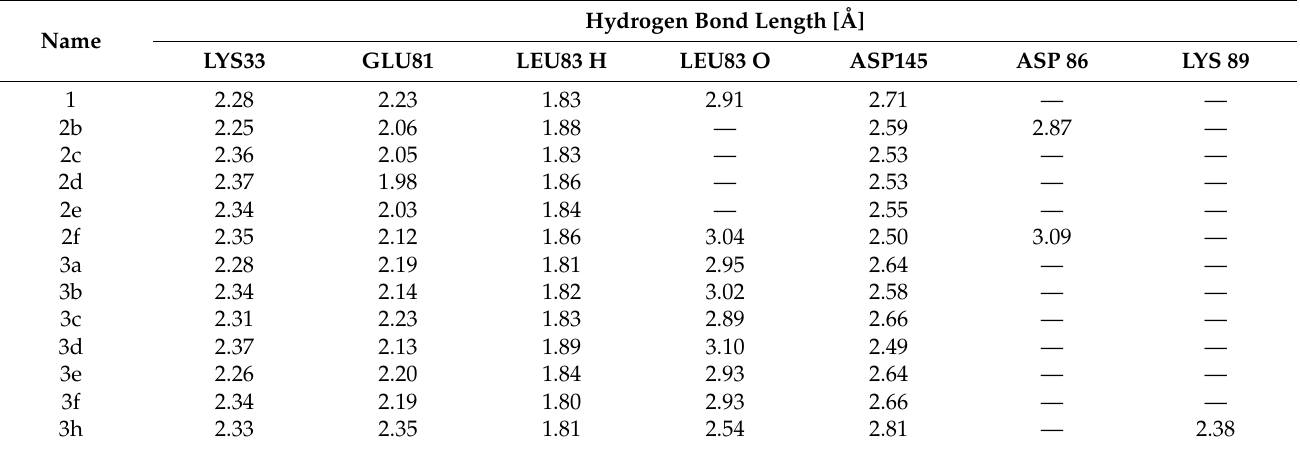
Table 4. The averaged values of RMSD for ligands and CDK2 protein for all steps used during structural analysis.